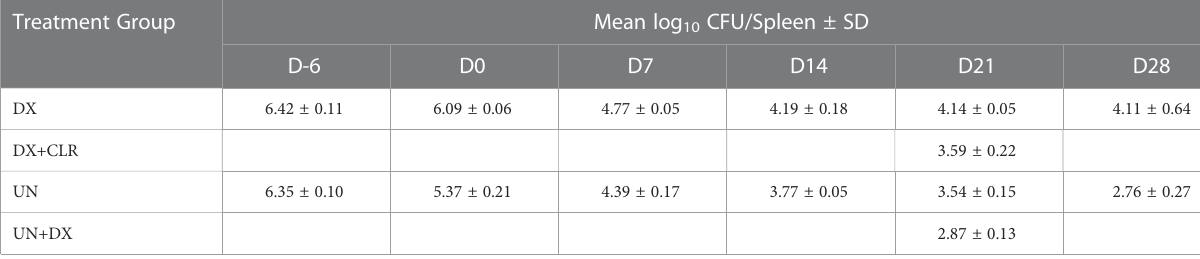
TABLE 8 M. abscessus burden in the spleens of mice receiving different corticosteroid treatments. Treatment